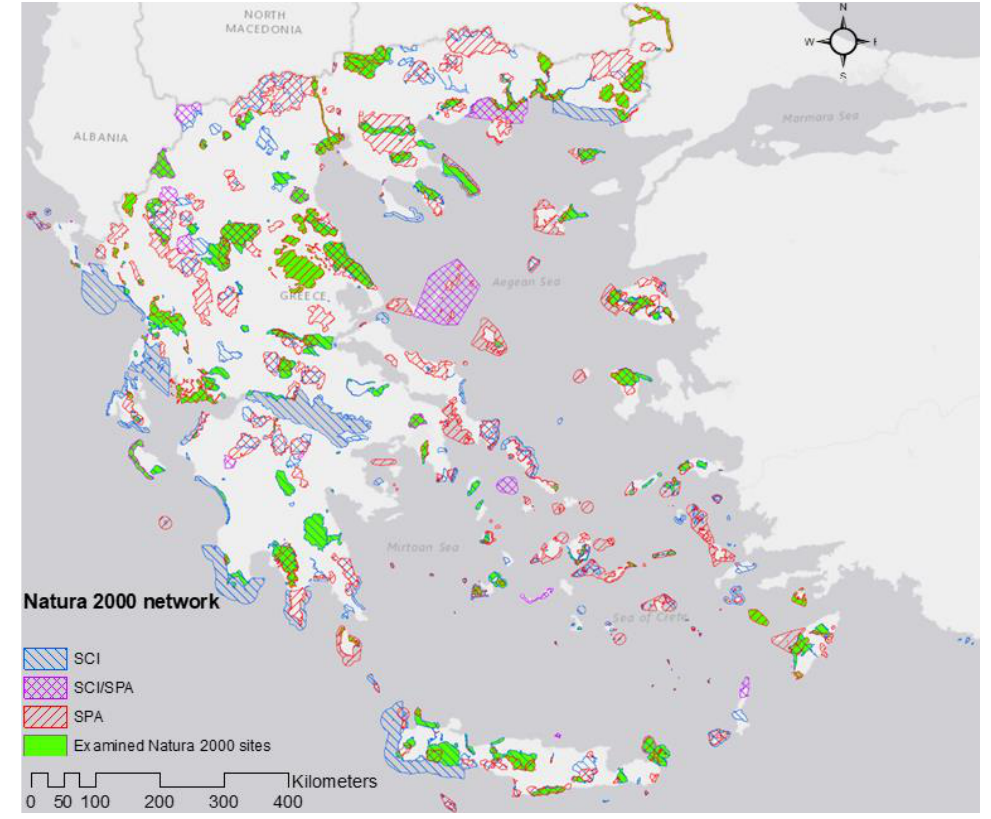
Figure 1. Distribution map of the Natura 2000 sites (SCI, SCI/SPA, and SPA) in Greece. The green- colored areas indicate the sites investigated in this study.